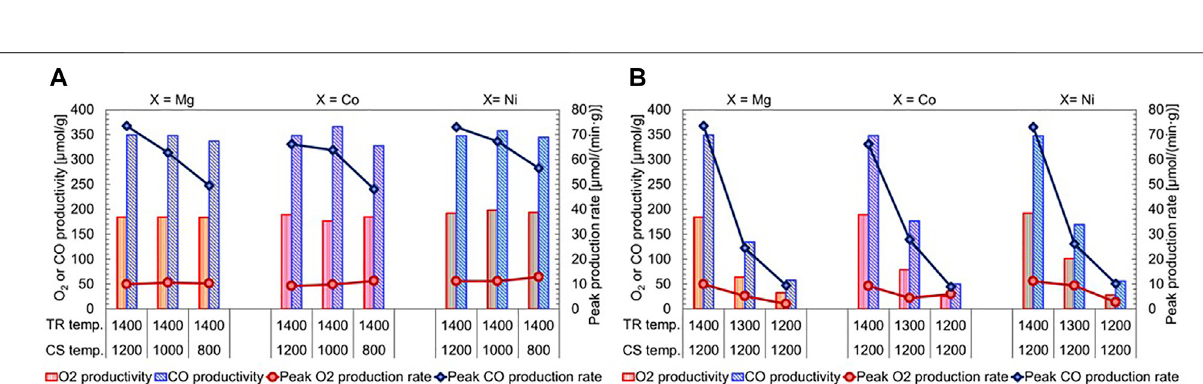
FIGURE 6 | Effects of (A) CS and (B) TR temperatures on the redox activity of substituted LSMs in group C. (A) the samples were subjected to the TR step at a temperature of 1,200 ° C for 90 min, and the subsequent CS step was performed at temperatures of 800 ° C – 1,200 ° C for 30 min (B) the TR step was conducted at temperatures of 1,200 ° C – 1,400 ° C for 90 min, and subsequently the CS step was performed at a temperature of 1,200 ° C for 30 min. Each temperature of TR and subsequent CS step shows in below the fi gure. The O 2 and CO productivities correspond to left Y-axis, while the peak rates of production correspond to right